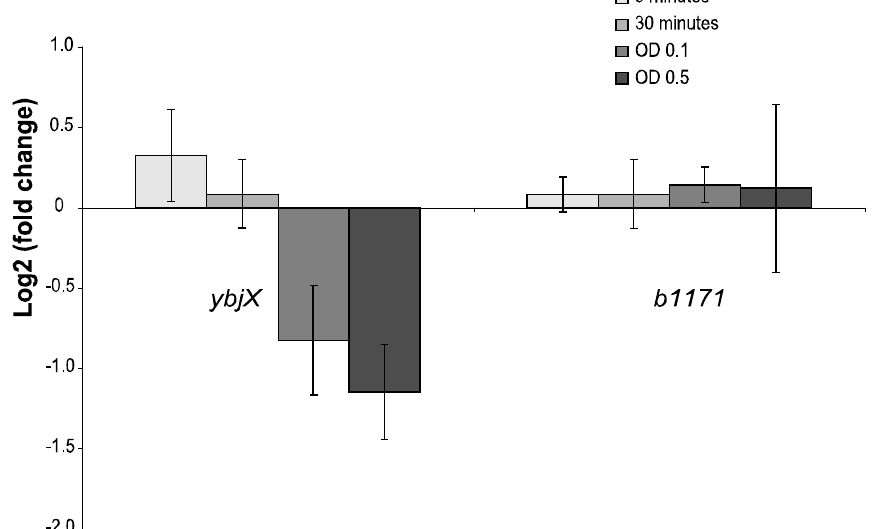
Figure 3. Real-time PCR results from a competitive growth experiment of mixed cultures of knock-out strain b1171 and the wild type, and knock-out strain ybjX and the wild type. The time points used were equivalent to sampling points 1, 2, 3 and 4 shown in Figure 1. The log 2 of fold change was calculated using the ∆∆ CT calculation based on gene accD and the kanamycin resistance gene related to the growth in the presence and absence of BC. The expression was based on 3 biological